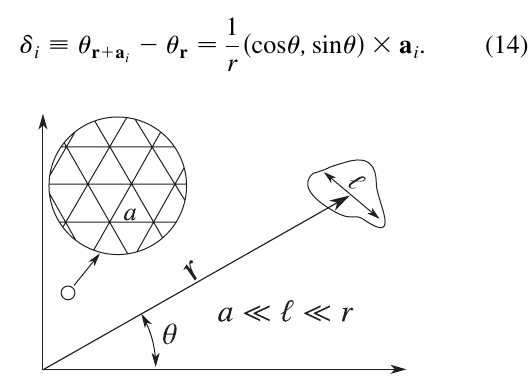
FIG. 6. In a region of size ‘ far away from the vortex, the perturbation Hamiltonian is translationally